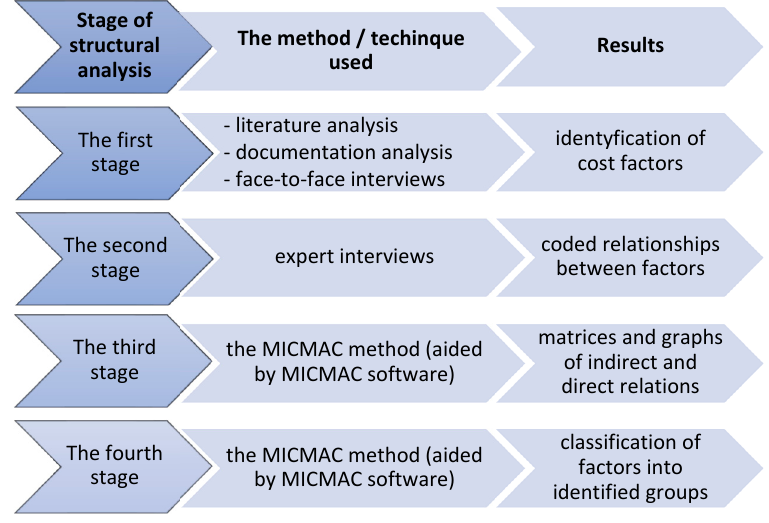
Figure 5. Methods and results of the conducted analysis.